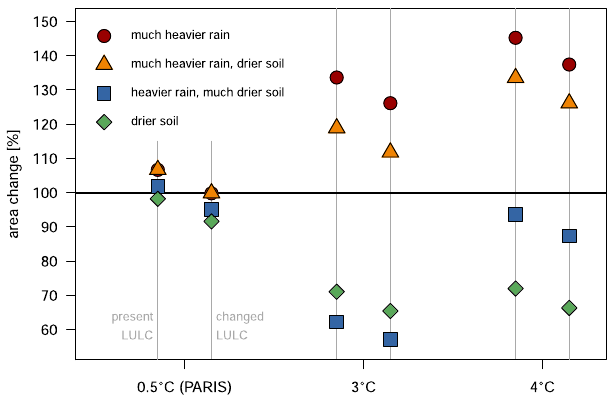
Fig. 5 Storylines of affected area in the Feldbach region. Change in the area affected by a high landslide occurrence probability of at least 68% within a 10 m × 10 m cell (corresponding to the 95th percentile of landslide occurrence probability across all cells in the Feldbach region in present climate) during the 2009 event happening in a warmer climate. The horizontal black line indicates the present-day reference. For each global warming level, the left symbol shows changes under present-day LULC conditions, the right symbol changes under a climate change resilient